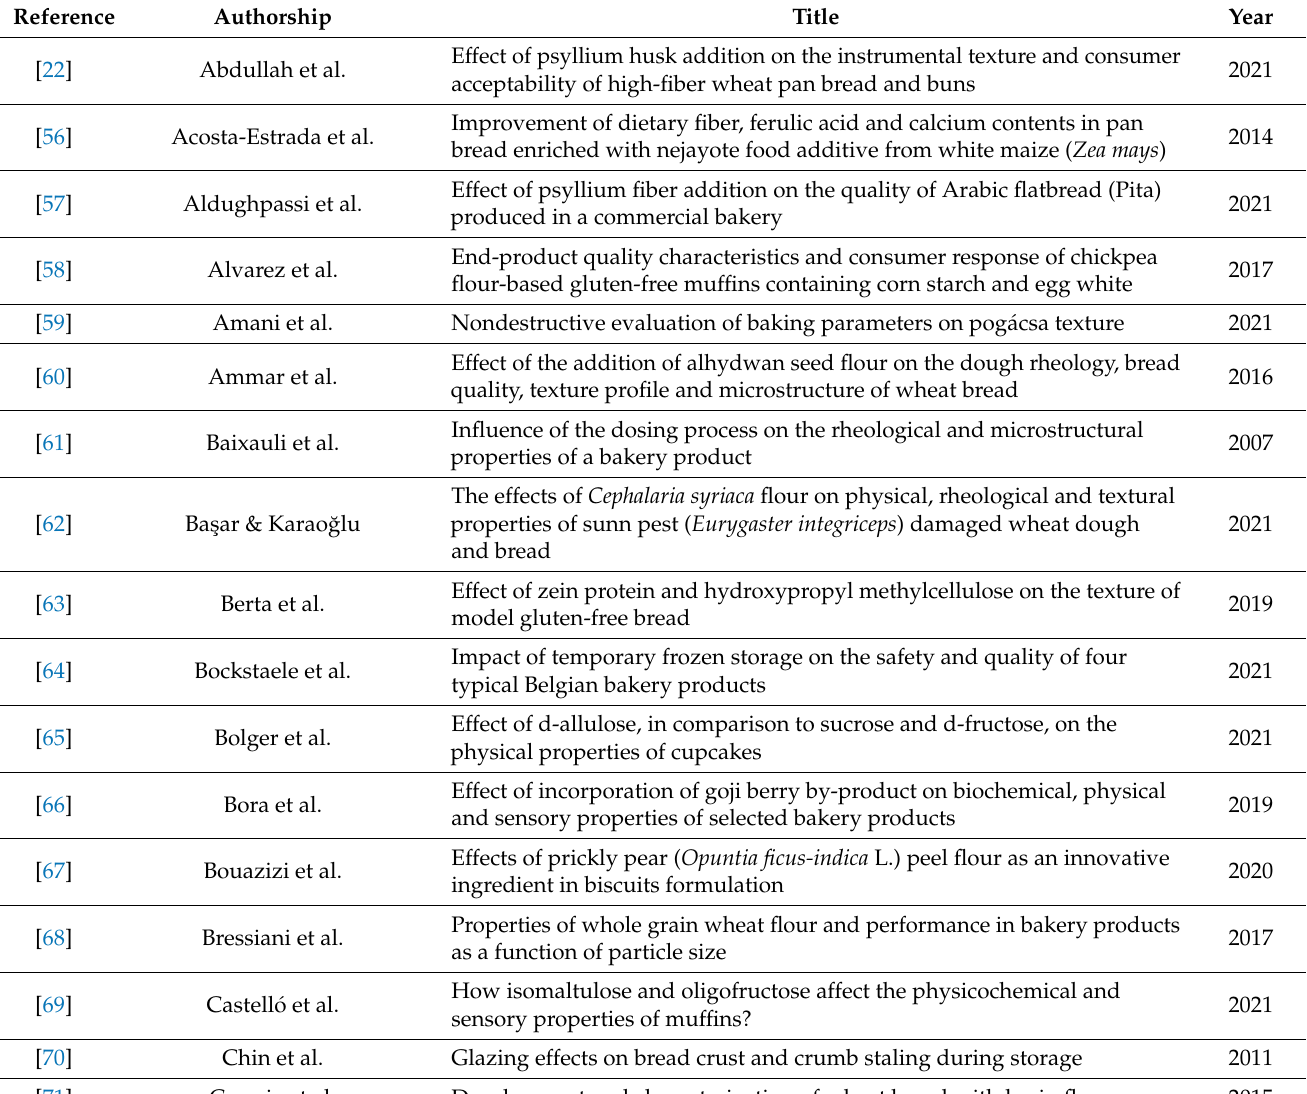
Table A1. Studies about the textural properties of bakery products in the